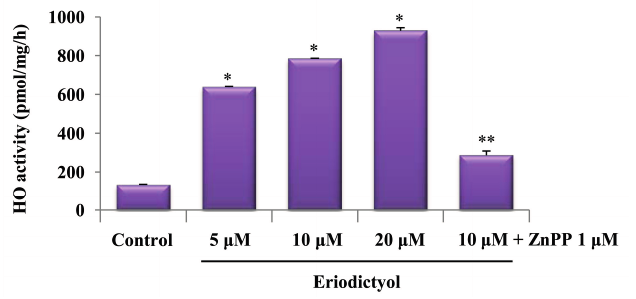
Figure 3. HO-1 activity in cells was measured 18 h after treatment with various concentrations of eriodictyol. Each bar represents the mean ± SD of four independent